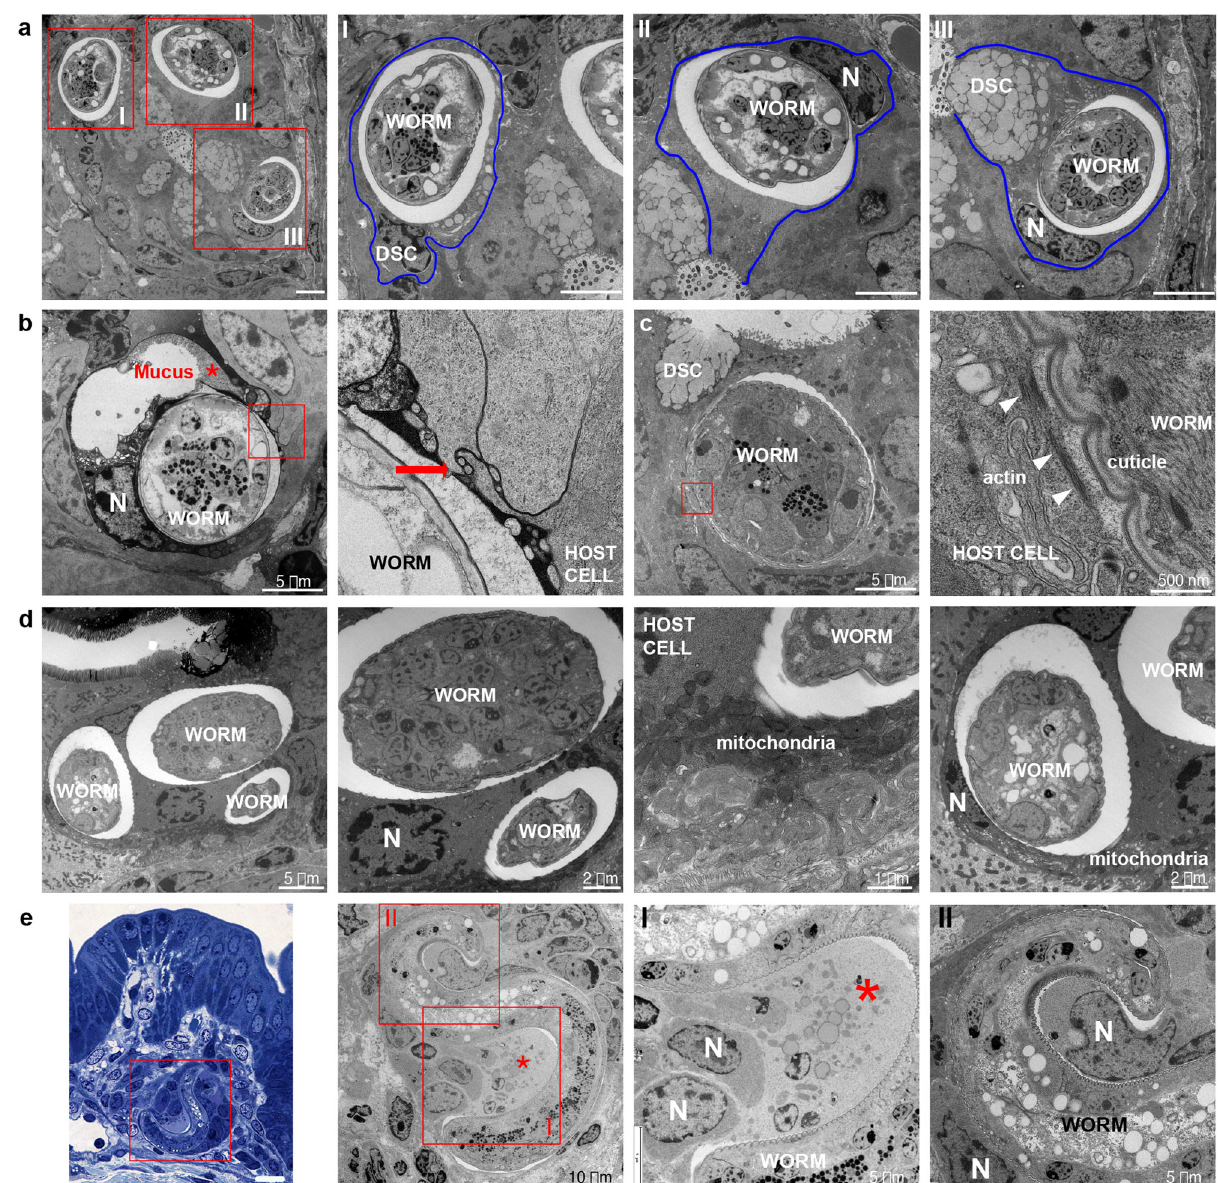
Fig. 2 Whipworm L1 larvae become completely intracellular and are in direct contact with the cytoplasm of their host cells. TEM images of transverse sections from caecum of mice infected with T. muris . a Whipworm L1 larvae infecting DSCs (identi fi ed by the mucin secretory granules; insets I and III) and other IECs at the base of the crypt (inset II) at 3 h p.i. Scale bars 5 μ m. Blue lines show the cellular membranes of the host cells. b , c L1 larvae infecting DSCs in the caecum of mice 3 h p.i., note: b potential mucus discharge (red asterisk) and tannic acid staining (black secretion) revealing complex carbohydrate in the host cell cytoplasm and between cells (inset, red arrow); c host cell cytoskeleton reorganization of actin fi laments adjacent and parallel to the cuticle of the larvae (inset, white arrowheads). d L1 larvae infecting several IECs in the caecum of mice at 24 h p.i. Host cells display DNA condensation and fragmentation (pyknotic nuclei, characteristic for the onset of apoptosis) and their nuclei and mitochondria are displaced by the worm. e Toluidine blue- stained (scale bar 20 μ m) and TEM images of transverse sections from caecum of mice infected with T. muris , showing a syncytial tunnel formed by L1 whipworm larvae through IECs (72 h p.i.), and depicting liquefaction of cells (inset I, red asterisk) and nuclei in early stages of apoptosis (inset II). N, nuclei. Images are representative of 15 larvae found during the fi rst 72 h of infection across two independent experiments with three mice per timepoint (3, 24 and 72 h p.i.)